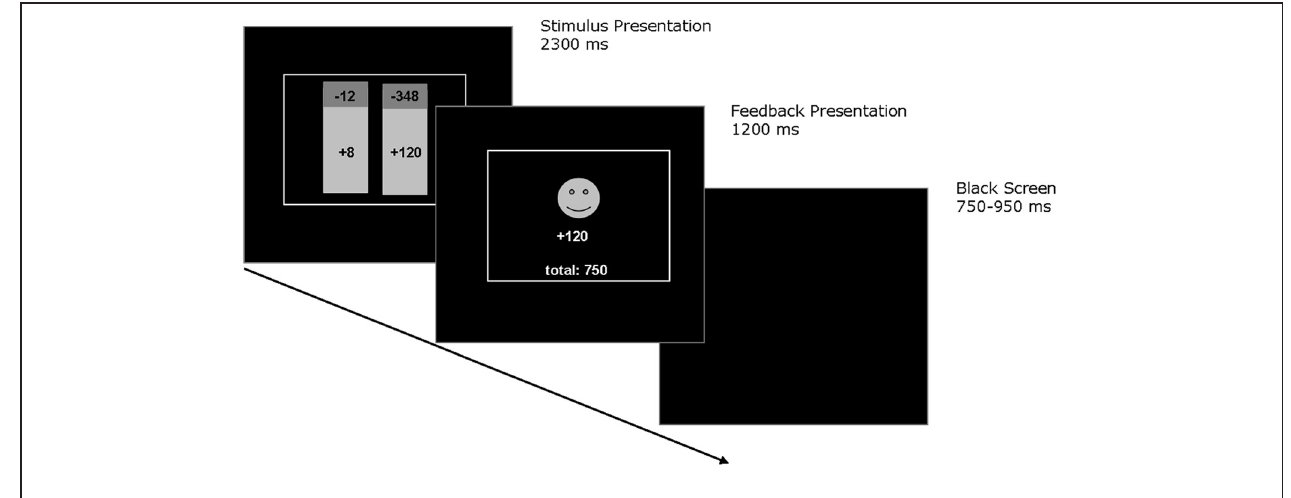
FIGURE 1 | Schematic depiction of the probabilistic two-choice gambling task. During each trial, participants were asked to choose between two options that were represented visually by a histogram. The colors of the histogram indicated the relative probability of gaining (colored green) which was always 75% and the relative probability of losing (colored red) which was always 25%. The current amount of gains and losses associated with each option were displayed